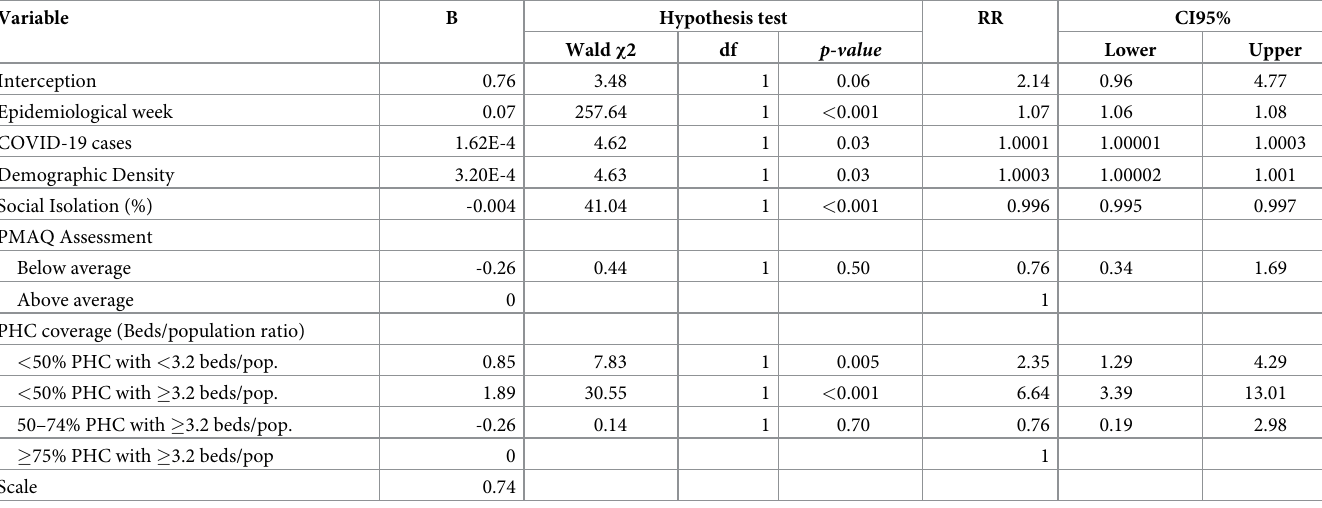
Table 5. Adjusted model for the association with COVID-19 deaths in the time-series of twenty epidemiological weeks in Northeastern cities in Brazil. Variable